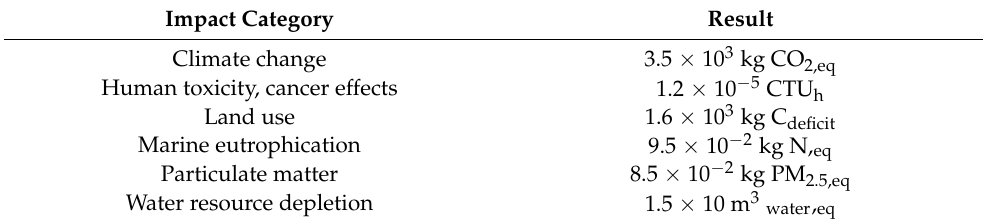
Table 2. LCA results for considered impact